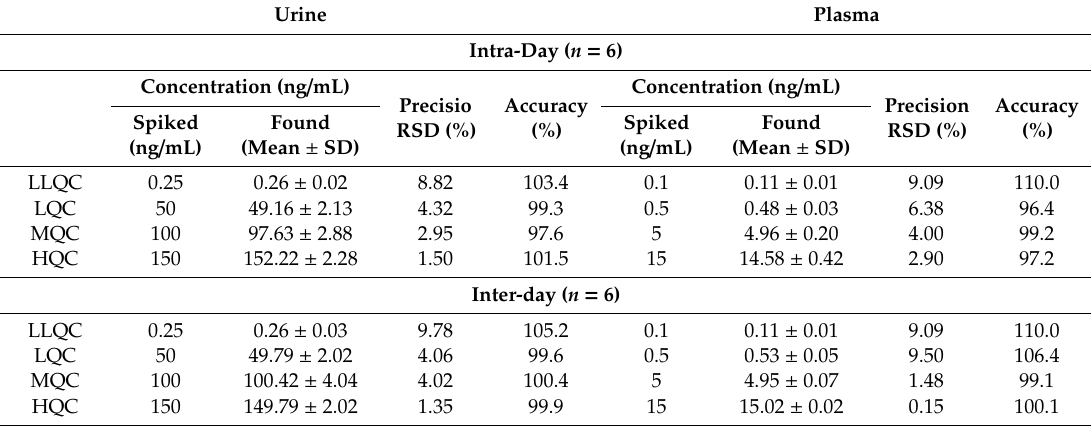
Table 3. Intra-day and inter-day precision and accuracy for the determination of IDA in plasma and urine samples by the SPE-LC-FD method ( n = 6),